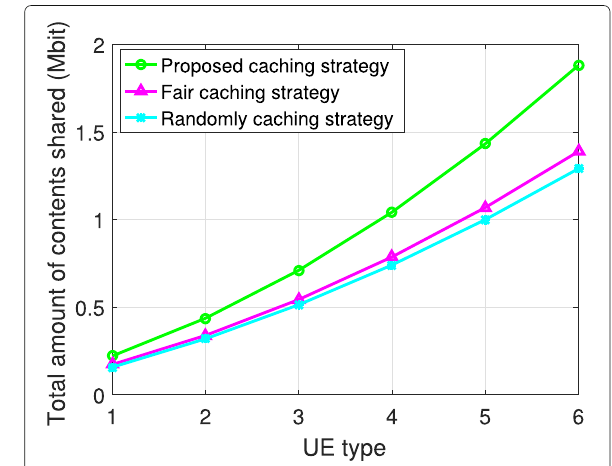
Fig. 2 Total amount of contents shared versus the UE type